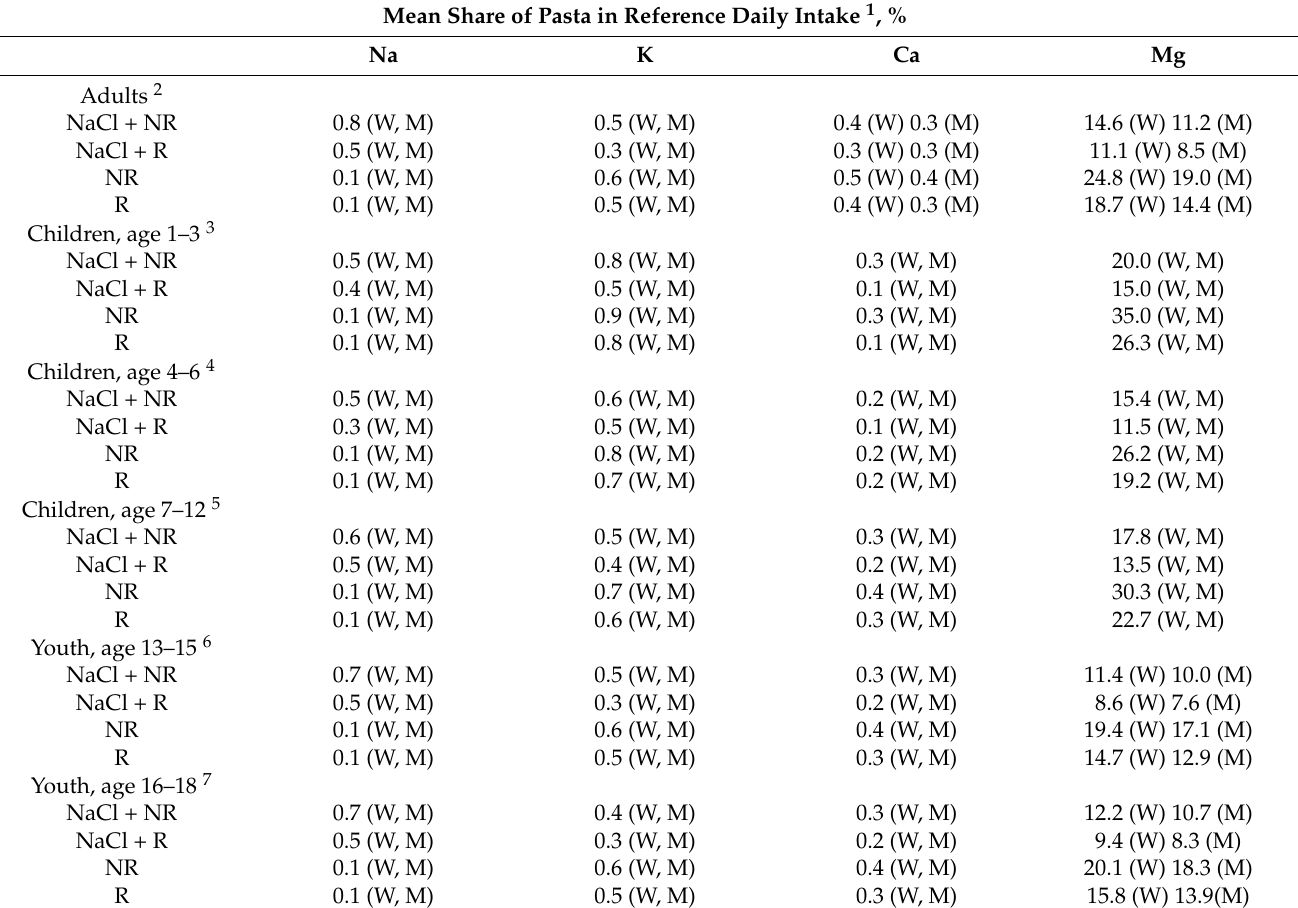
Table 5. Share of pasta products in the supply of Na, K, Ca, and Mg in the diets of respective groups of Poles, g. Mean Share of Pasta in Reference Daily Intake 1 ,